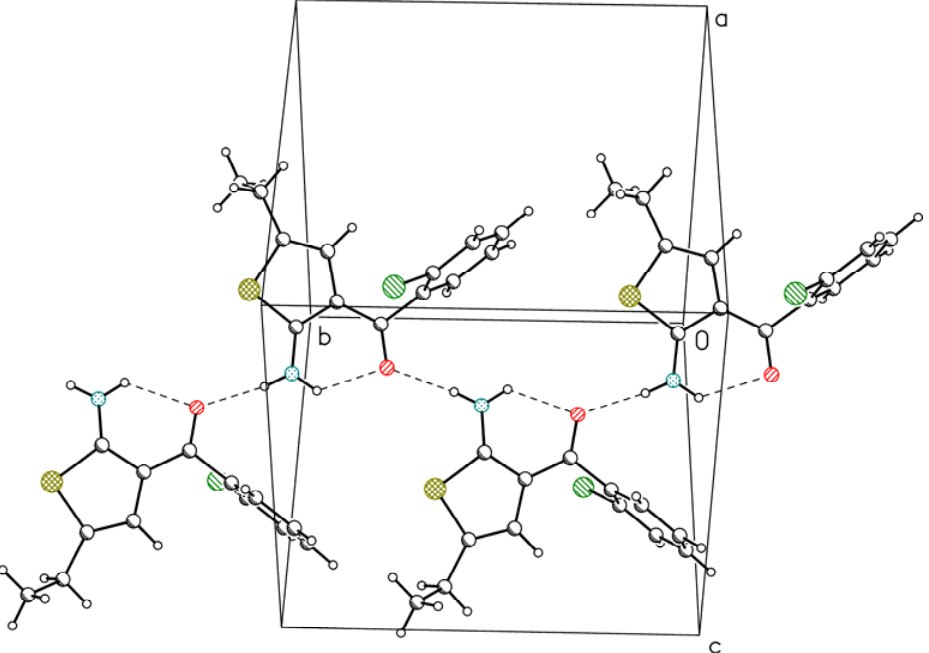
Figure 4. Hydrogen-bond chain of molecule 2 [12]. Hydrogen bonds are depicted as dashed lines.